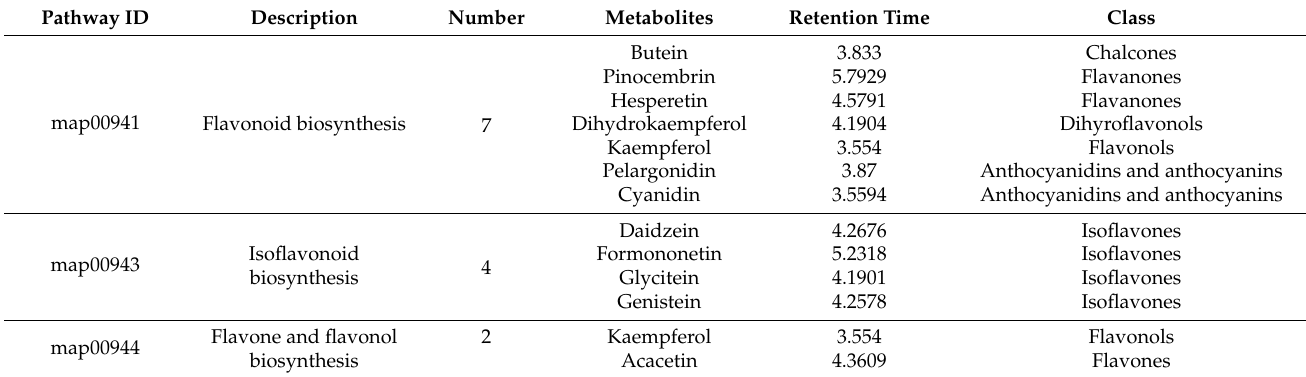
Table 2. Enrichment analysis of metabolic pathways of differential